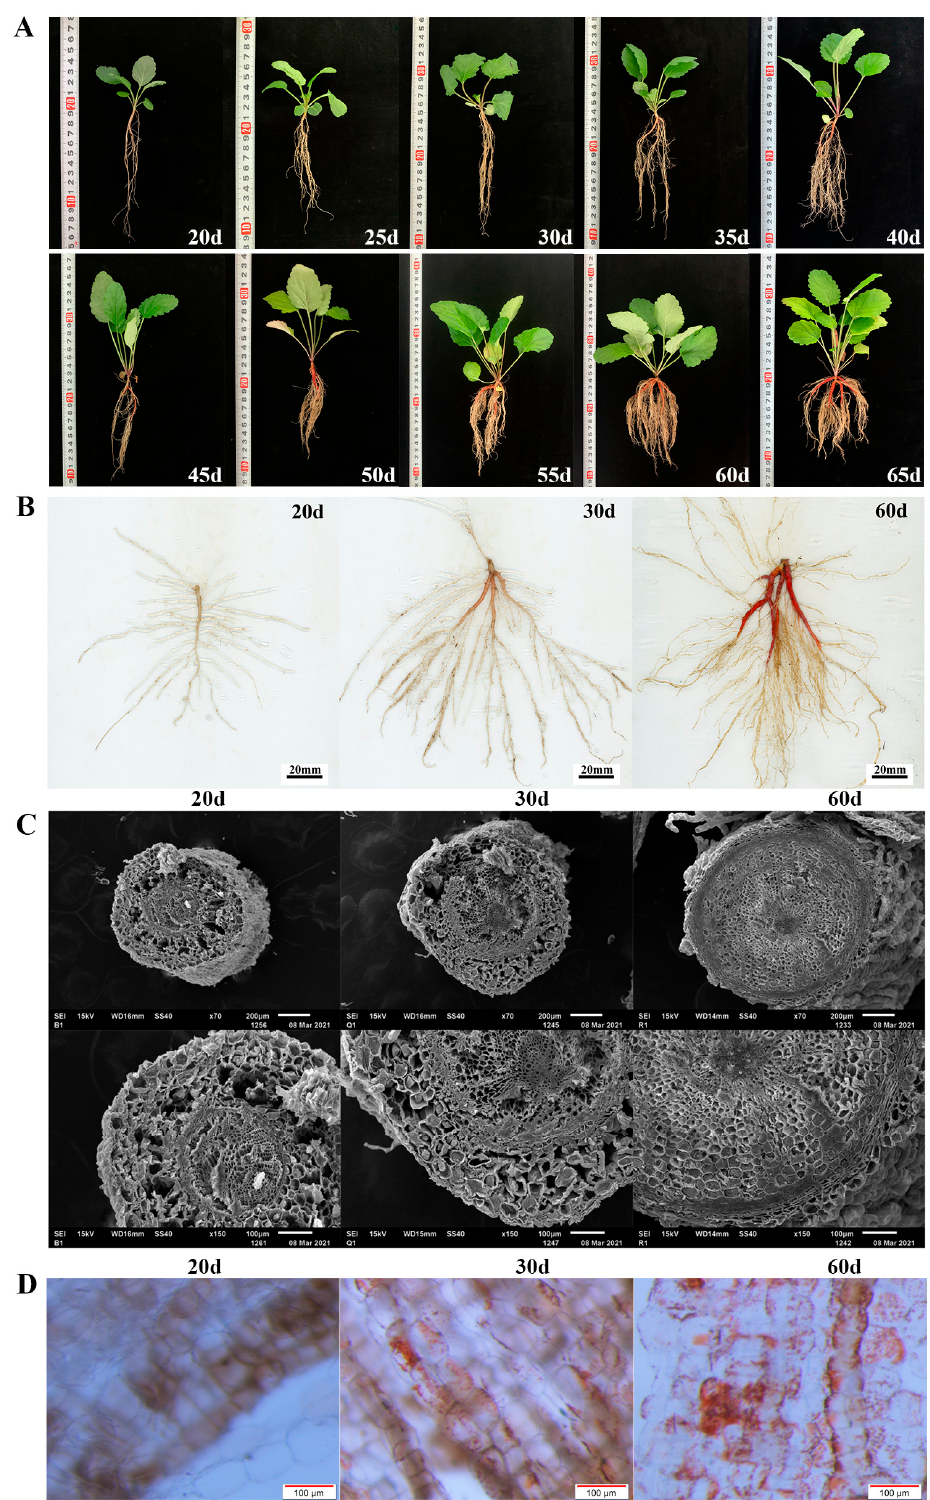
Figure 1. ( A ) Morphology of S. miltiorrhiza seedlings within 60 days of growth. ( B ) Scans of roots of S. miltiorrhiza seedlings grown for 20d (white root, B), 30d (light red root, Q), and 60d (red root, R). ( C ) The root cross-section of S. miltiorrhiza seedlings grown for 20, 30, and 60 days was observed under scanning electron microscope. ( D ) The root epidermis was observed under a stereomicroscope, and the magnification was 11.5 ×